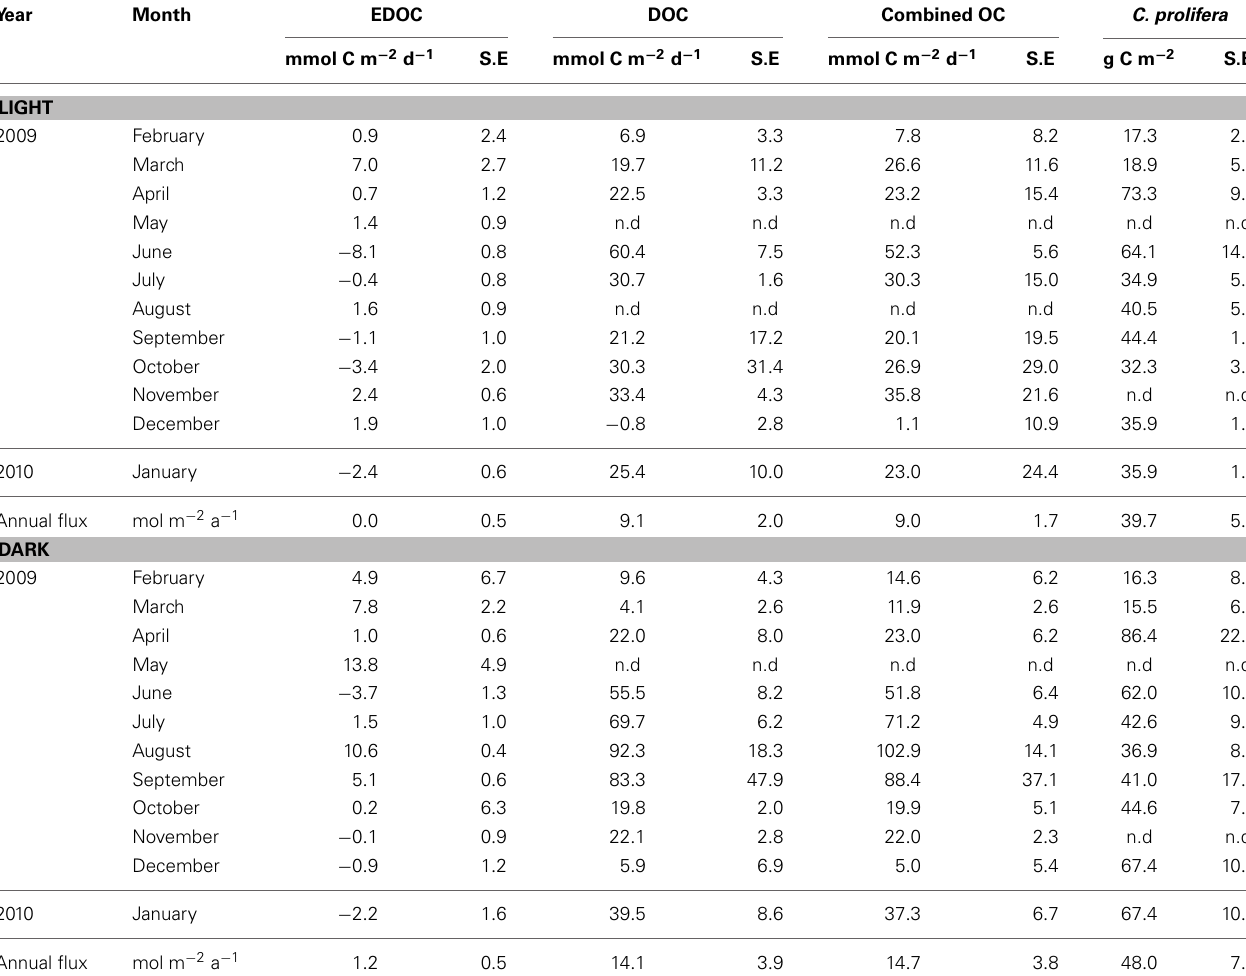
Table 2 | Net EDOC and DOC fluxes in light and dark incubations and biomass of Caulerpa prolifera standing stocks in the core incubations from samples collected in the bay of